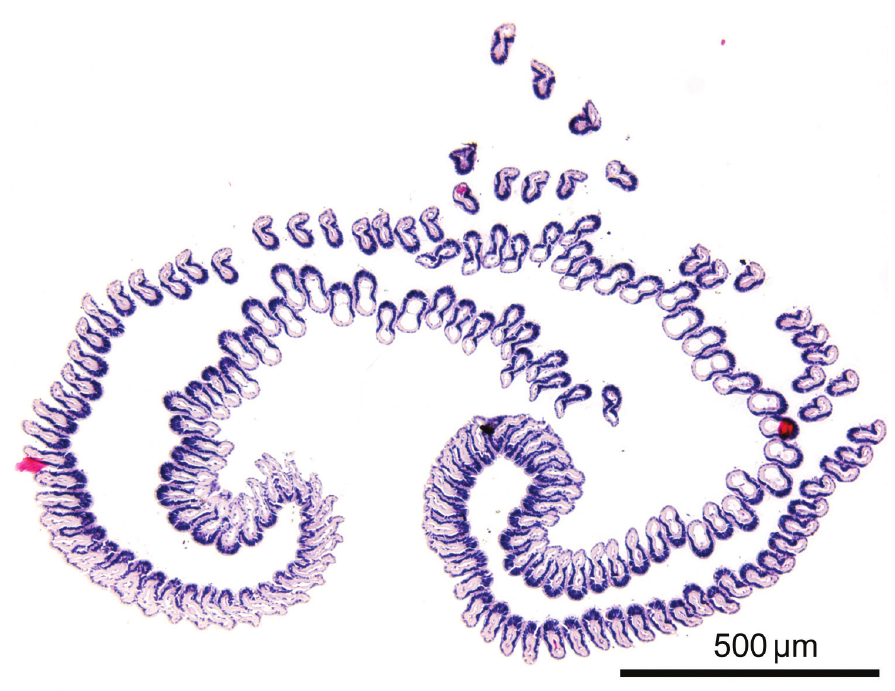
Figure 9. Phoronis emigi sp. n., NSMT-Te 713 (paratype), transverse section through the basal part of the